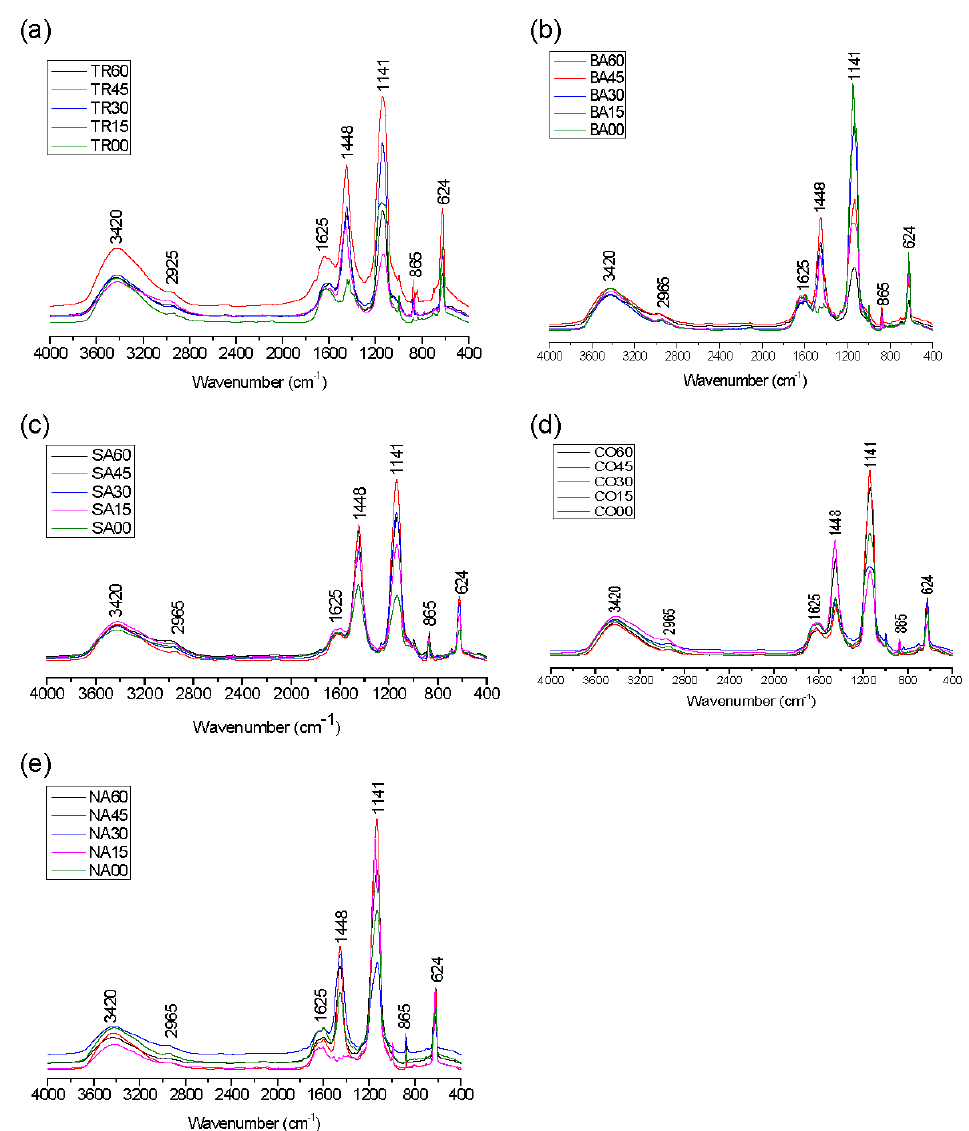
Figure 1. FTIR spectra of the humic acid (HA) fraction in composts made from poultry industry wastes mixed with ( a ) tree trimmings; TR ( b ) sugarcane bagasse; BA ( c ) sawdust; SA ( d ) cotton residues; CO and ( e ) Napier grass; NA. The number following the compost letter corresponds to the proportion of charcoal in the organic amendment, i.e., 0% 15%, 30%, 45%, and 60% (weight basis). For all spectra (Figure 1), a broad band of weak intensity was identified at the end of composting in the region near 3420 cm − 1 , commonly attributed to the O–H stretching. The region from 3200 to 2500 cm − 1 is characterized by asymmetric stretches of C–H bonds with possible intramolecular bonds between phenols; the band is generally weak and may not even be observed, which is supported by the weak signal identified at 2965 cm − 1 in all amendments. This signal is important because it correlates linearly with compost humifi- cation and maturity; in contrast, the presence of a strong signal from aliphatic C ‒ H stretch- ing is associated with poorly humified amendments [46–48]. Thus, the low intensity ob- served for this signal indicates that growing substrates were highly humified, stable and mature, which would presumably enhance parsley yield. For all spectra, an inconspicuous signal was identified in the vicinity of 1625 cm − 1 , which can be assigned to aromatic ring stretching of lignin monomers which is characteristic of compost [49]. Meanwhile, the